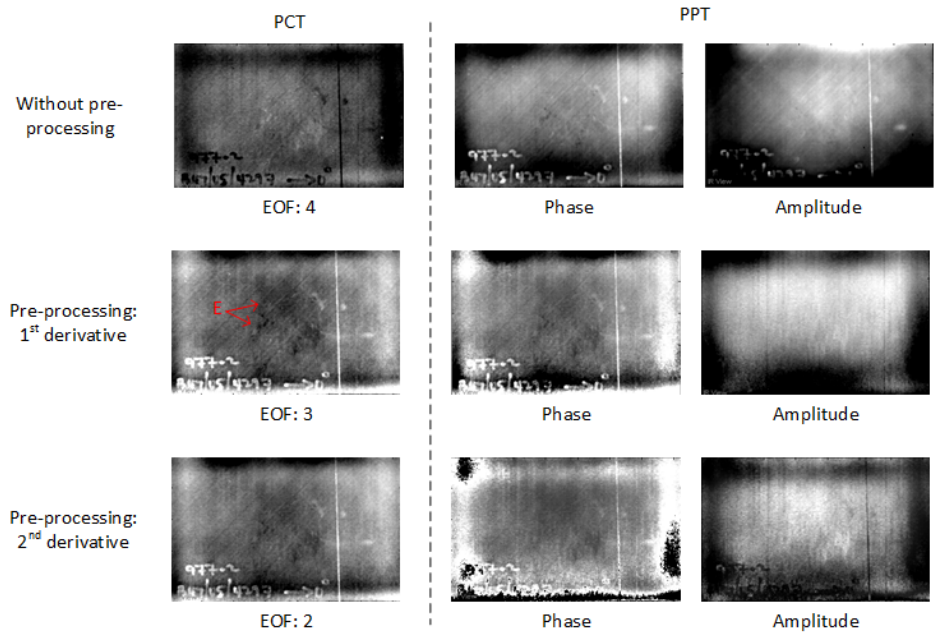
Figure 13. Thermographic results in PT for CFRP 03.